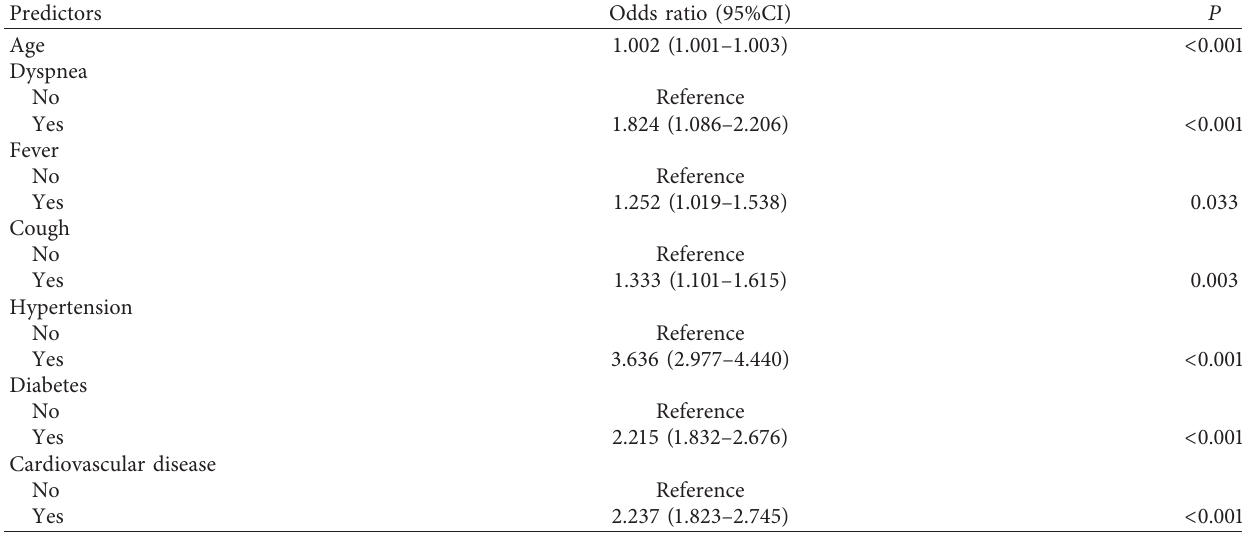
Table 3: Predictor variables of mortality in patient COVID-19 based on the results of multiple logistic regression.